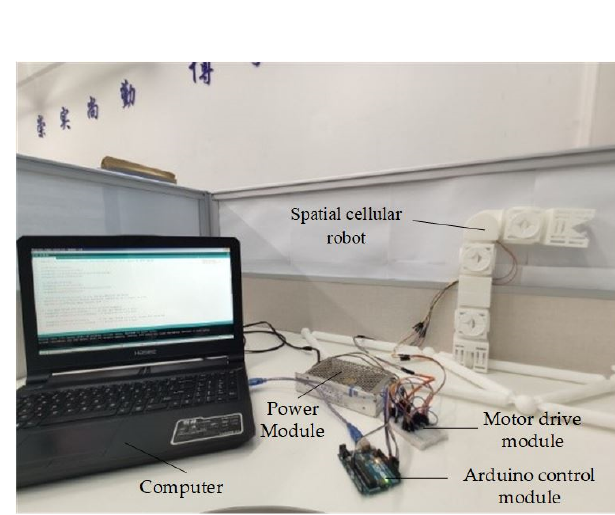
Figure 13. Simulation experiment